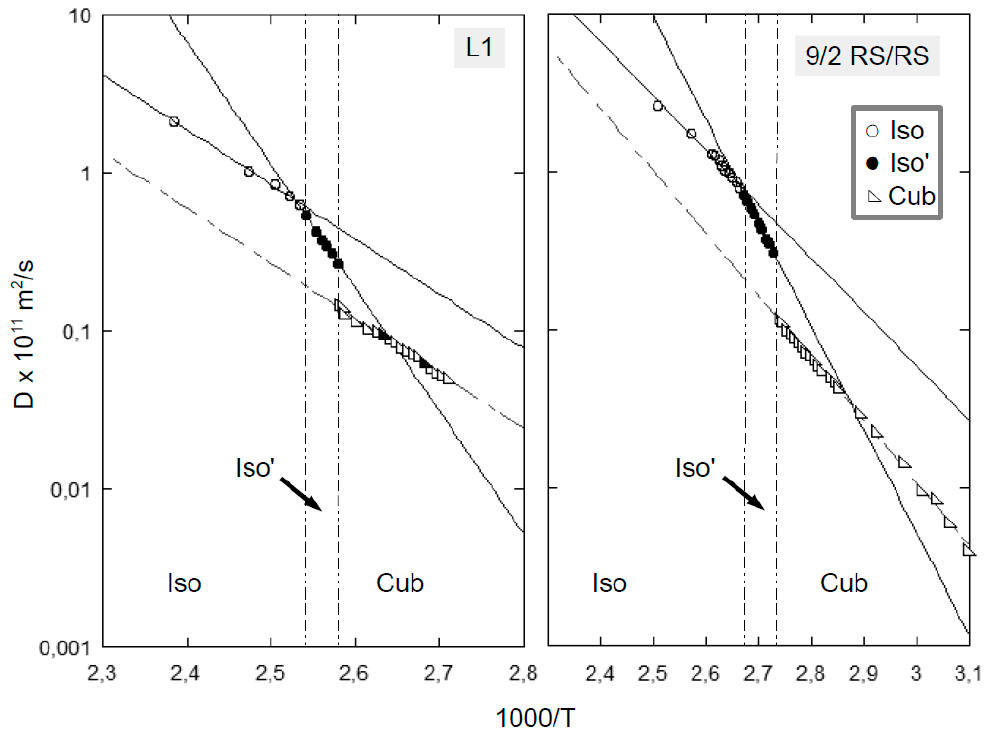
Figure 3. Diffusion coefficients measured in the three mesophases (isotropic, isotropic’ and cubic phases) of the two samples on cooling from the isotropic phase. (On the right ) Data for 9/2 RS/RS are reproduced from Ref. [29] by permission of the publisher Taylor & Francis Ltd. (On the left ) In the L1 sample, diffusion coefficients measured varying the diffusion time and gradient directions, as discussed in the text, are also shown as black triangles.